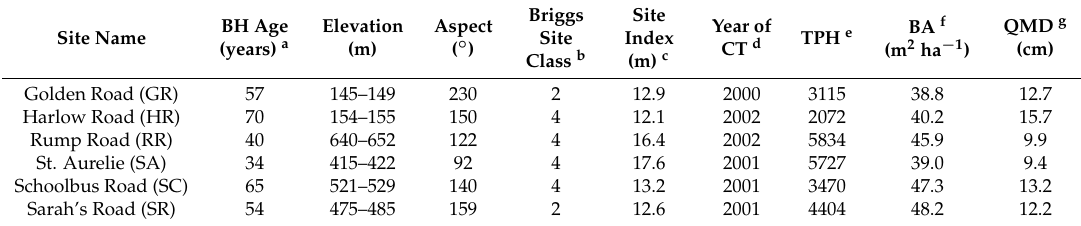
Table 2. Description of study sites at time of Commercial Thinning Research Network (CTRN)